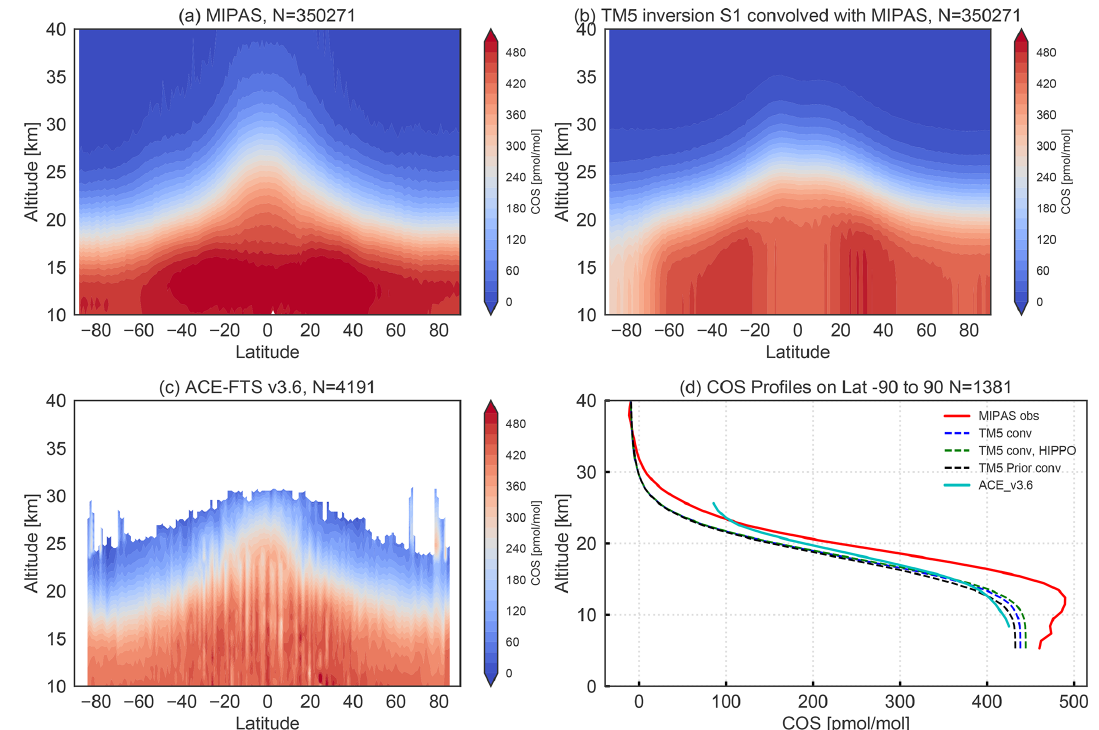
Figure 10. Comparison of MIPAS and ACE-FTS v3.6 with TM5 results from inversions for 2009. (a) Latitude–height contour plot of MIPAS; (b) TM5 S1 convolved with the MIPAS AK; (c) ACE-FTS profiles; (d) average of collocated profiles for MIPAS (red), TM5 convolved with MIPAS AK from inversion S1 (blue), TM5 convolved from inversion S1 (with HIPPO observations assimilated) (green), TM5 convolved prior (black) and ACE-FTS. In (d) TM5 and MIPAS profiles are collocated with respect to ACE-FTS profiles within a temporal offset of 6h and a spatial distance of 5 ◦ . The number of collocated profiles is